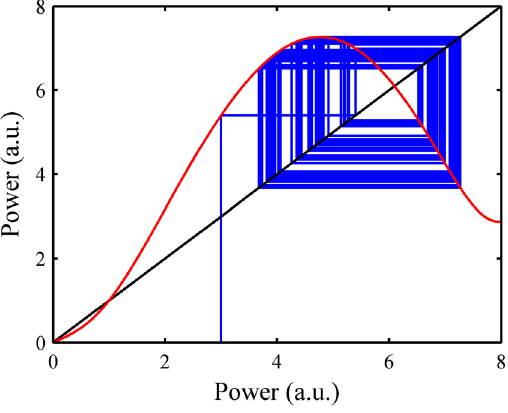
Figure 5. Orbit diagram for a chaos pulse in the laser. Red line: Nonlinear mapping function of the laser; Blue line: Orbit diagram of the pulse; Black line: x =